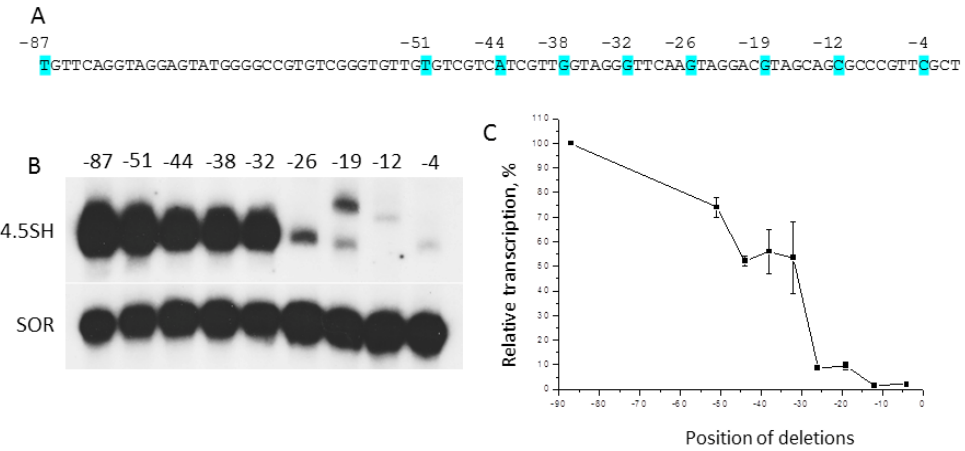
Figure 1. Effect of deletions in 5 ′ -FS of 4.5SH RNA gene on its transcription in transfected HeLa cells. ( A ) 5 ′ -FS of murine 4.5SH RNA gene. The nucleotides at the edges of deletions are marked in blue. ( B ) 4.5SH RNA gene transcripts revealed by Northern blot hybridization. The numbers above the lanes indicate the length of the remaining 5 ′ -FS of the gene in the transfected constructs. Shrew SOR Short Interspersed Element (SINE) was used as a control for transfection. (C) The graph of transcription rate versus the length of the remaining 5 ′ -FS of 4.5SH RNA gene (error bars, SD, n = 3).